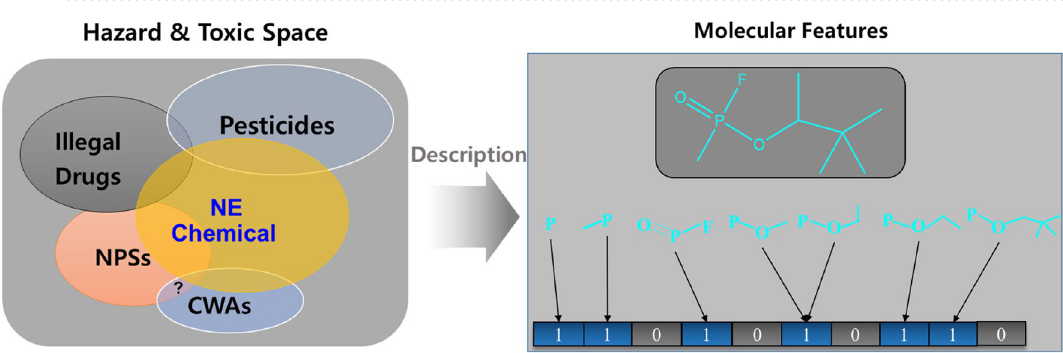
Figure 2. Conceptual presentation of hazard and toxic space and molecular featurization of chemicals in the